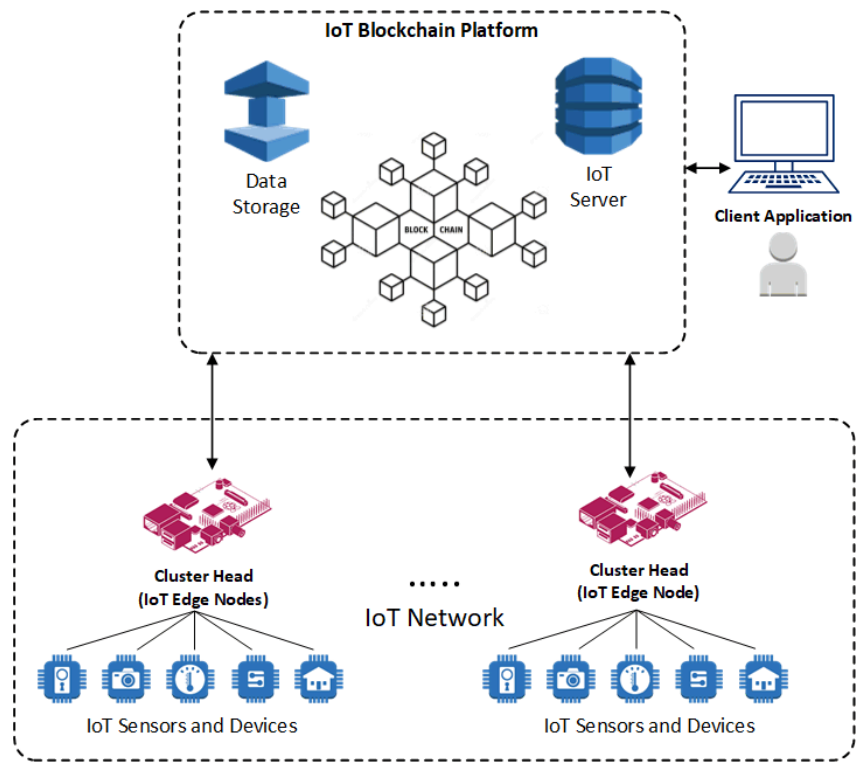
Figure 2. Conceptual framework of the integrated IoT blockchain